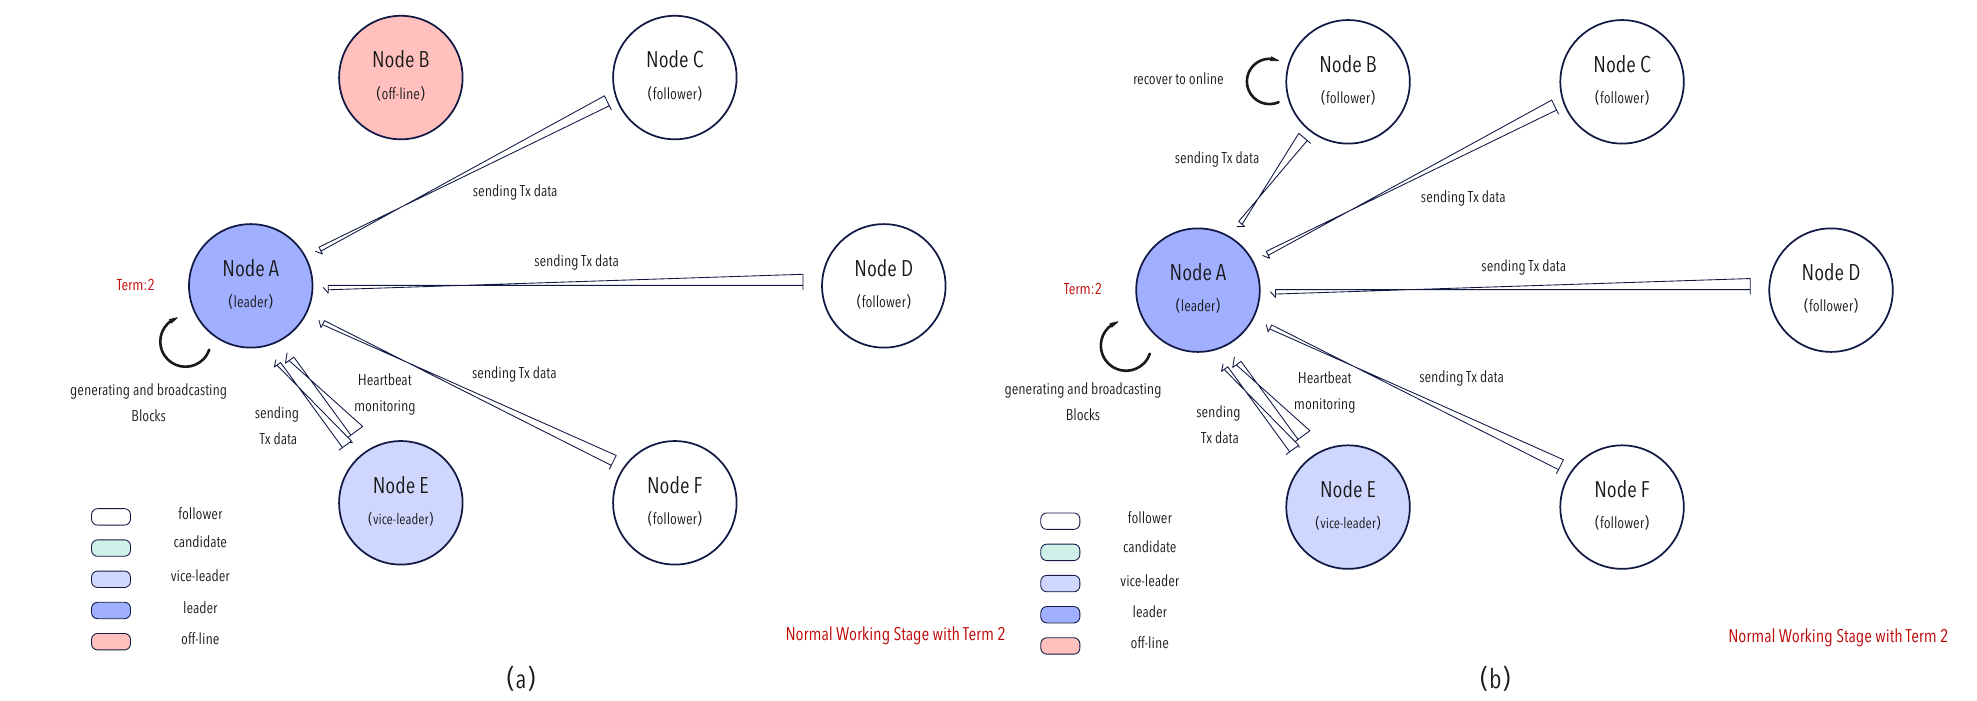
Figure 5. Consensus flow chart: ( a ) normal working stage with TERM 2 (Node B offline); ( b ) normal working stage with TERM